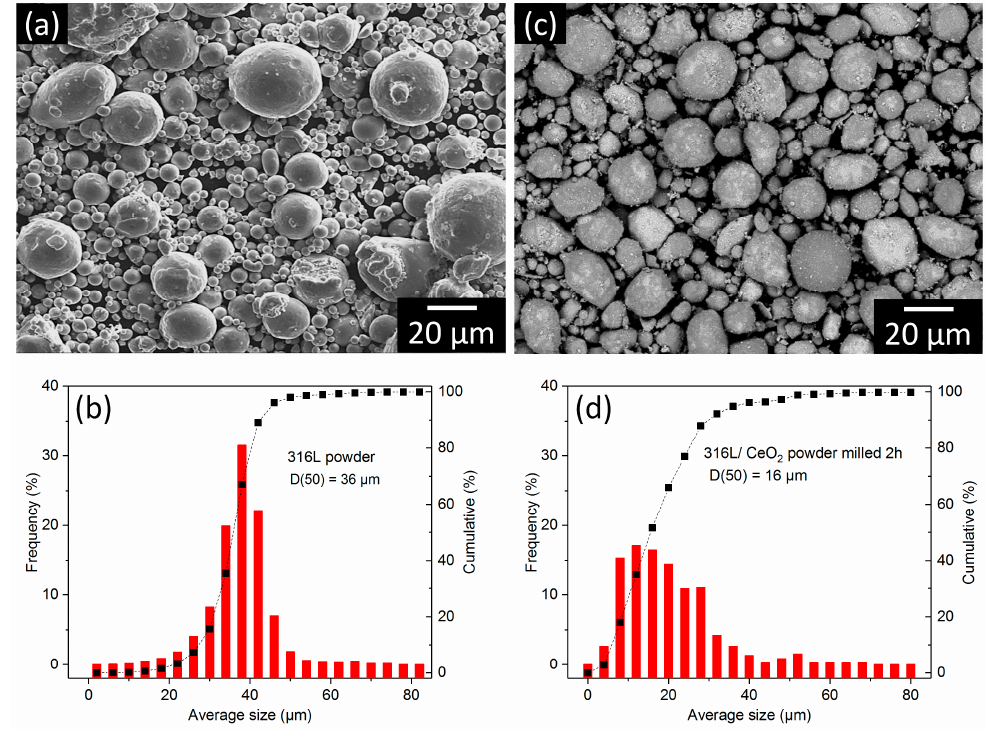
Figure 1. Powder morphology and particle size distribution for: ( a , b ) as-atomized pure 316L powder and ( c , d ) 316L/CeO 2 powder mixture ball milled for 2 h.